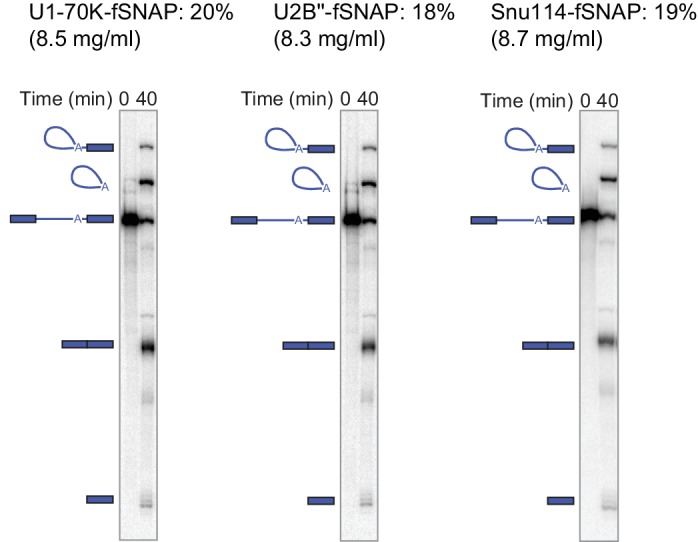
Bulk splicing efficiency and protein concentration for the nuclear extracts used in this study.2nd step splicing efficiency was calculated as in Figure 1 at 40 min reaction time (N = 1). Protein concentration was determined using Bradford protein assay using bovine serum albumin as a standard (N = 1).